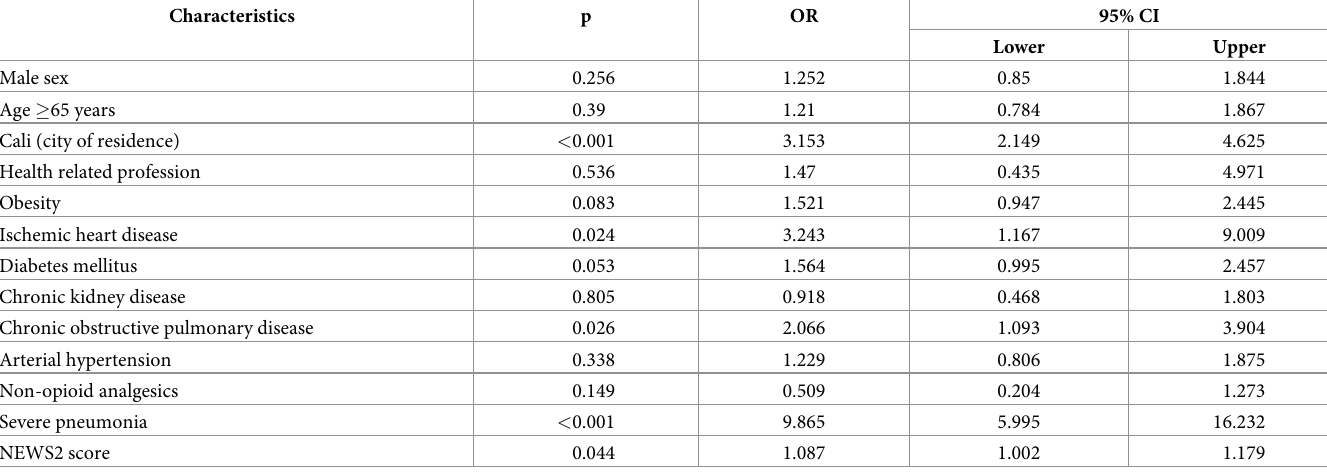
Table 5. Binary logistic regression of variables associated with the probability of admission to the intensive care unit in patients with a diagnosis of SARS-CoV-2. Characteristics